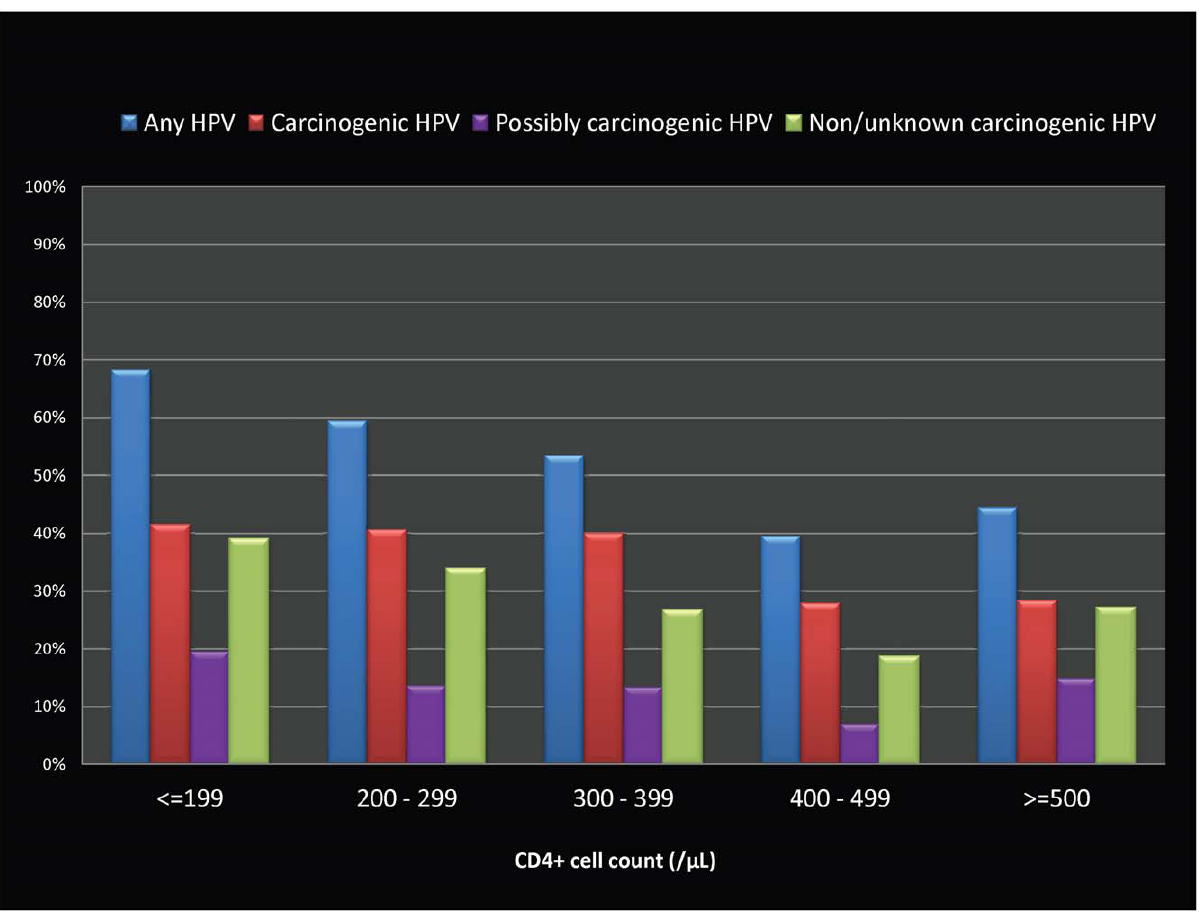
Figure 2. Bar graphs showing HPV genotype prevalence by CD4 + cell count categories among HIV-infected women in Pune, India. HPV prevalence levels (as percentages) are displayed on the Y-axis, with various carcinogenicity groupings (any HPV type, carcinogenic HPV type, possibly carcinogenic HPV types, and non/unknown carcinogenic types) shown as individual bar graphs grouped by CD4 + count categories ( # 199, 200–299, 300–399, 400–499, $ 500 / m L) on X-axis.